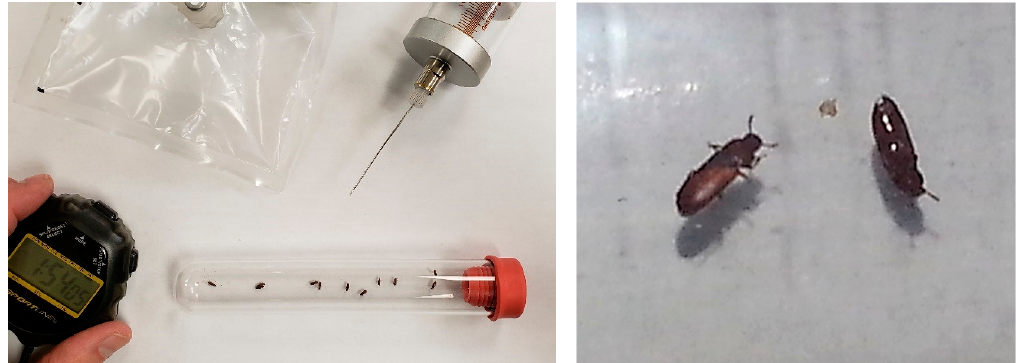
Figure 2. The photo on the left shows the glass exposure tube into which beetles were placed for the knockdown assays. The tube was closed with a large red injection septum, air was removed, and then a high concentration of phosphine from the holding bag was injected with the large glass gas-tight syringe to achieve 3000 ppm. The stopwatch was started to measure time to knockdown after the phosphine was added. On the right are two T. castaneum undergoing knockdown narcosis inside the glass tube with phosphine. The beetle to the left is upright and walking unsteadily, while the beetle to the right has fallen on its back and is moving its appendages.